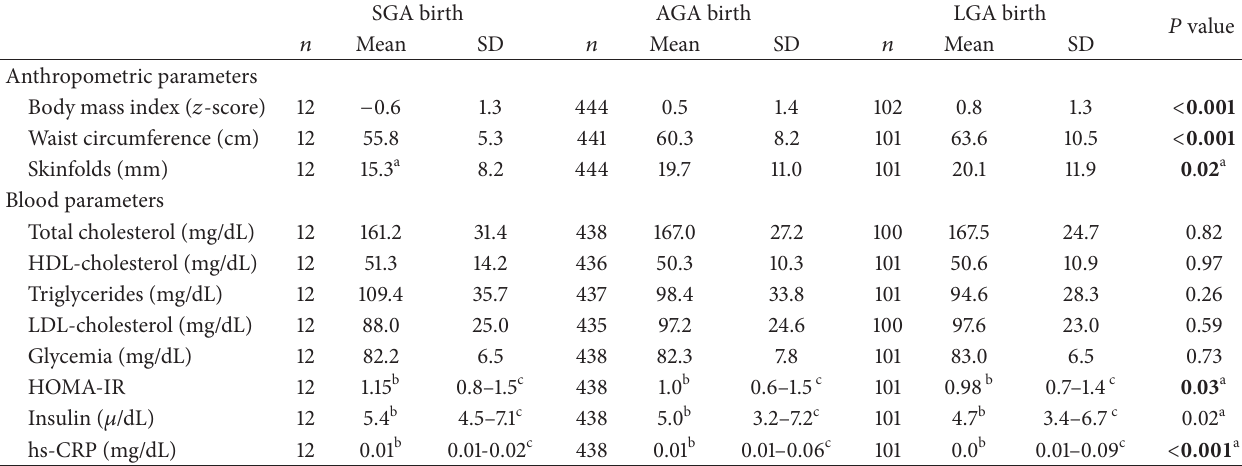
Table 2: Association between birth weight and anthropometric markers, lipid profile, glucose, HOMA-IR index, and hs-CRP in Brazilian school children ( 𝑛 = 612), 2013. SGA birth